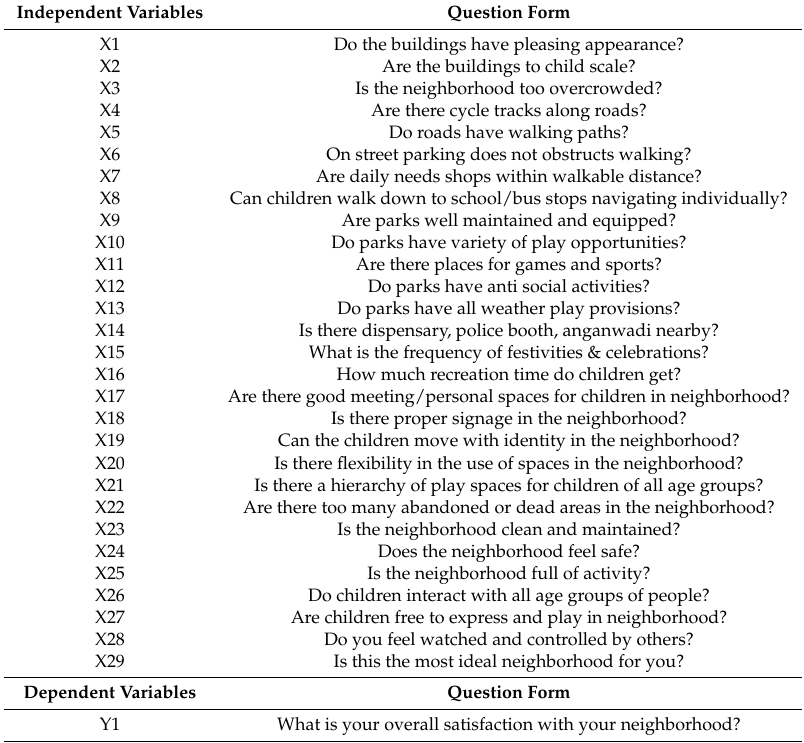
Table 3. Questions set from